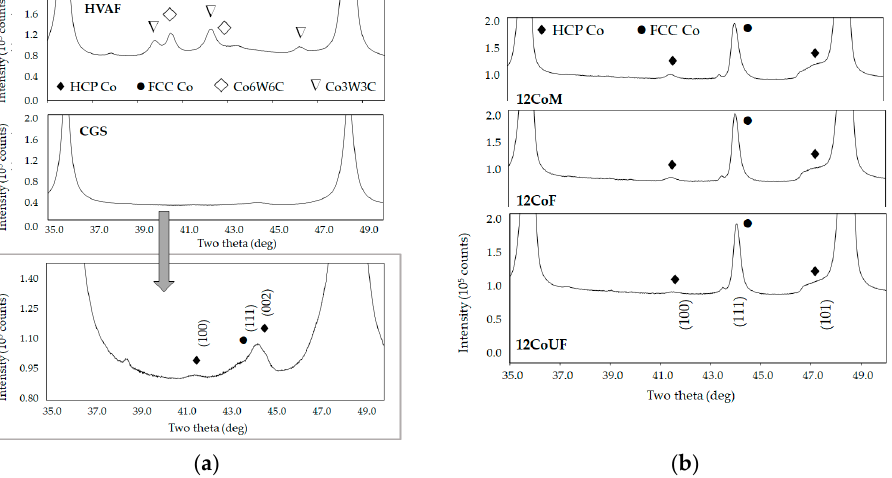
Figure 6. X-ray diffraction spectra ( a ) coatings and ( b ) bulk materials. Indexed patterns: PDF-ICDD-05-0727 for Co-HCP and 015-0806 for Co-FCC.